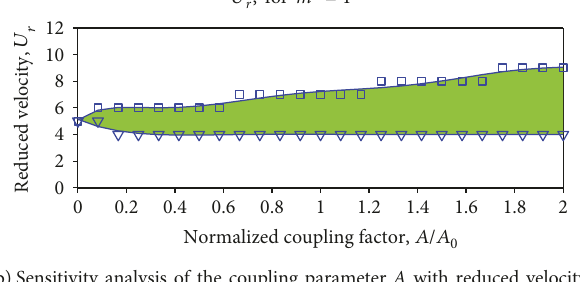
= 7 ° : VIV model ampl